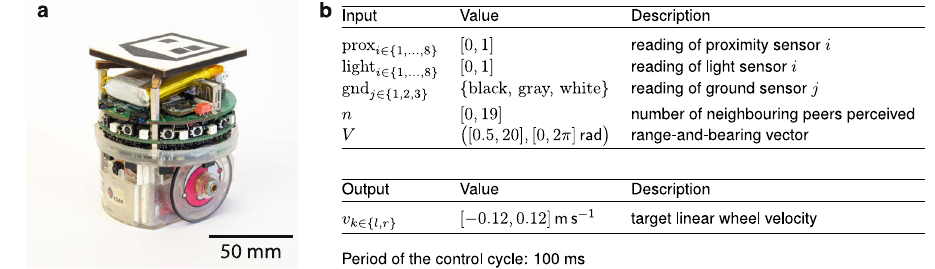
ð 1 ; ff b Þ , m 1 1 þ r m